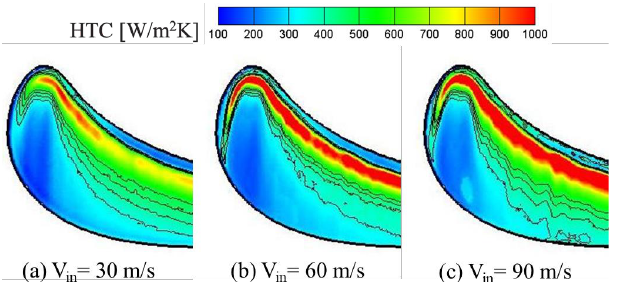
Figure 8. Detailed HTC of the plane tip at each velocity condition (x/C x < 0.4, plane tip).